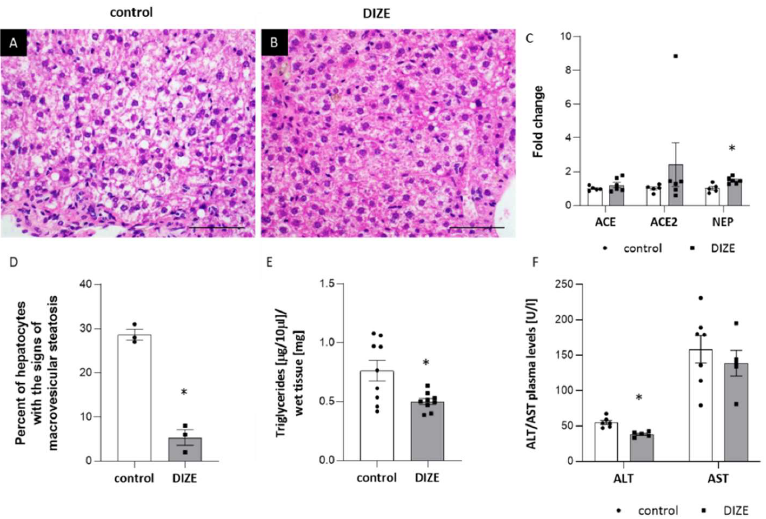
Figure 5. Influence of DIZE on the development of hepatic steatosis. Representative images